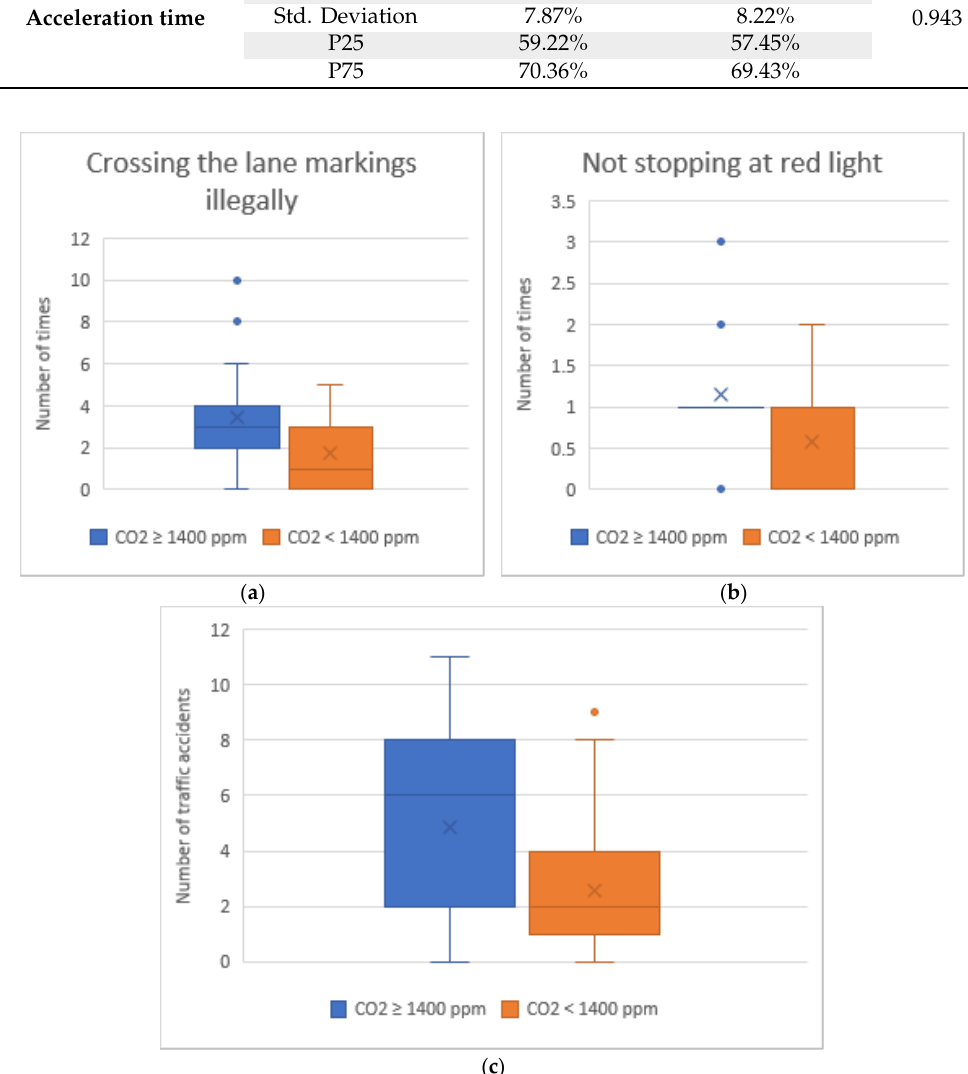
Figure 8. ( a ) Number of times drivers cross the lane markings illegally; ( b ) number of times that drivers do not stop at a red light; and ( c ) number of traffic accidents. Figure 9 captures the initial and final level of fatigue for each group of drivers. The results show that when the CO 2 concentration is high, the fatigue level increases by 12% compared to the initial value, while when the CO 2 level is low, the level of fatigue does not change.